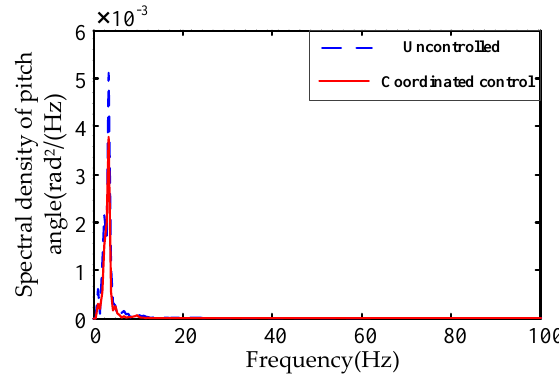
Figure 23. Vehicle pitch angle under the straight condition.